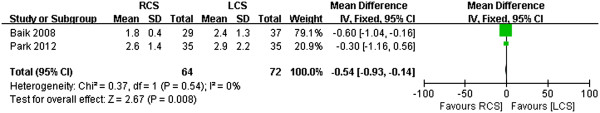
Meta-analysis of the times to the recovery of bowel function shown as a forest plot between robotic-assisted colorectal surgery (RCS) and laparoscopic colorectal surgery (LCS). The mean differences with 95% CIs are shown.